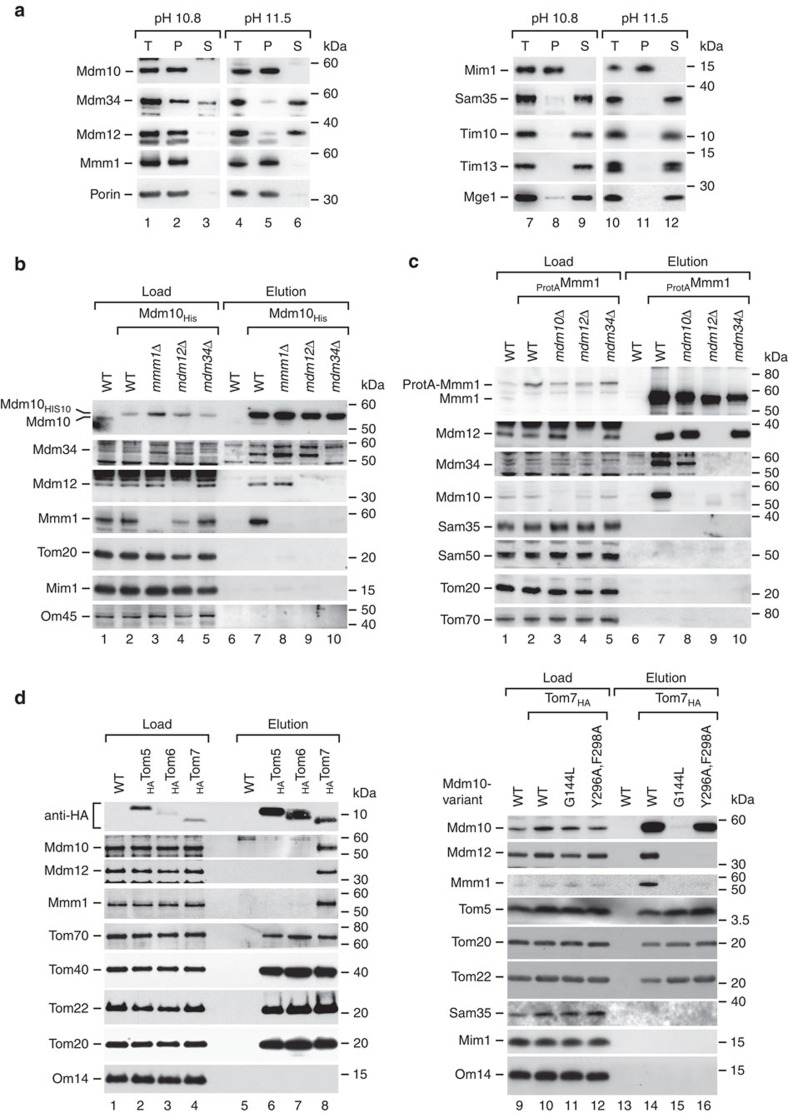
Mdm10 anchors the ERMES complex in the mitochondrial outer membrane.(a) Mitochondria isolated from wild-type (WT) cells were incubated in 0.1 M Na2CO3 at pH 10.8 and 11.5. Soluble and membrane-bound proteins were separated by ultracentrifugation. Samples were analysed by SDS–polyacrylamide gel electrophoresis (SDS–PAGE) and immunodetection with the indicated antisera. Comparable amounts of the total sample (T), membrane pellet (P) and supernatant (S) were loaded. (b) Whole-cell extracts of WT, Mdm10His, Mdm10His
mdm12Δ, Mdm10His
mdm34Δ and Mdm10His
mmm1Δ cells were solubilized with digitonin and subjected to affinity purification using Ni-NTA. Samples were analysed by SDS–PAGE and immunodetection. Load 2%, elution 100%. (c) Whole-cell extracts of WT, ProtAMmm1, ProtAMmm1 mdm10Δ, ProtAMmm1 mdm12Δ and ProtAMmm1 mdm34Δ cells were solubilized with digitonin and subjected to affinity purification via IgG-Sepharose. Load 2%, elution 100%. (d) Mitochondria isolated from WT, HATom5, HATom6 and HATom7 cells (left panel) or from WT and Tom7HA cells expressing the indicated mdm10 mutant forms (right panel) were solubilized with digitonin and subjected to affinity purification using anti-HA affinity matrix. Load 4% (left panel), 2% (right panel); elution 100%.